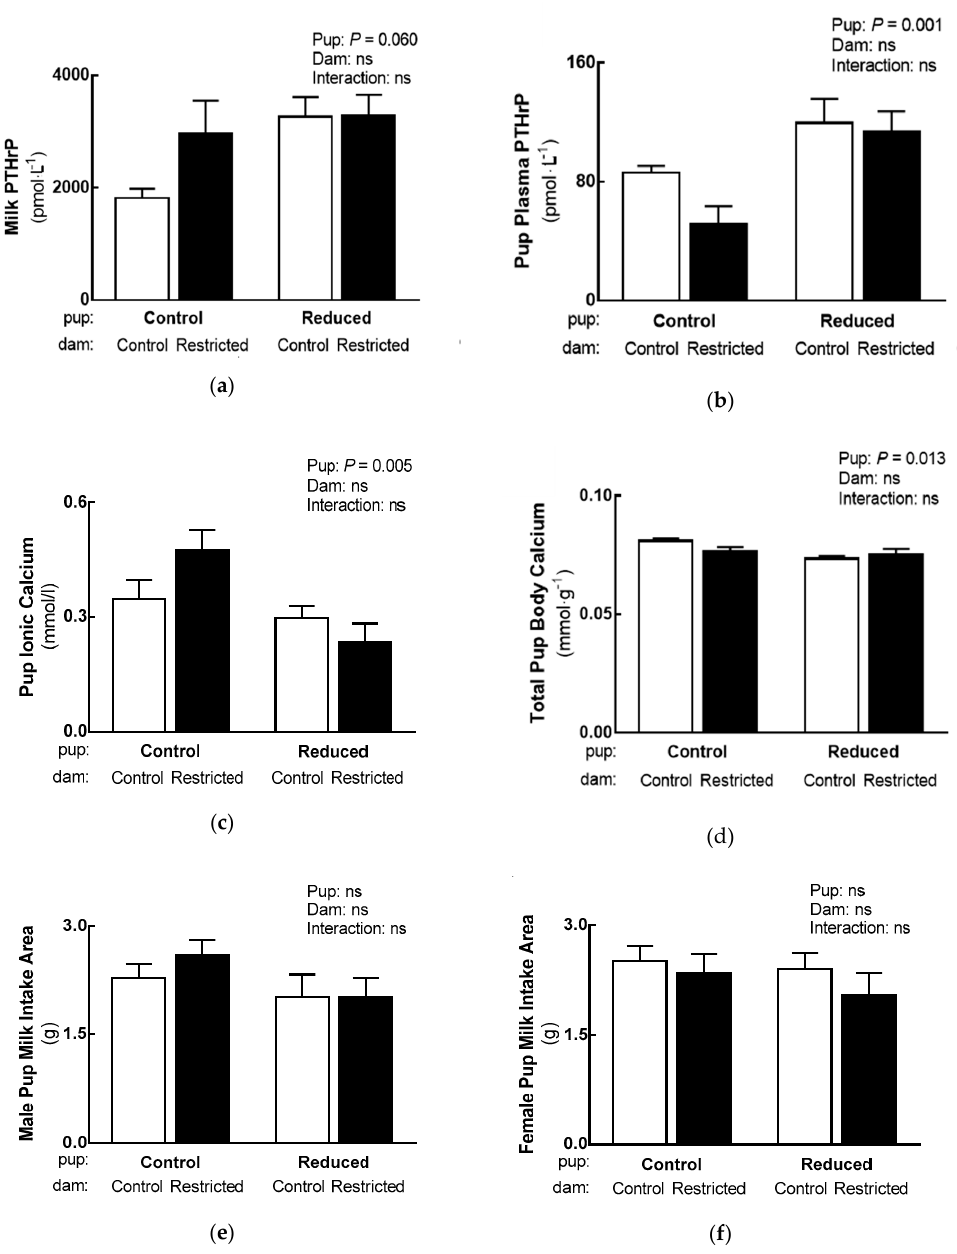
Figure 3. Effect reducing litter size has on pup calcium handling and milk intake ( n = 6–10 litter averages per group, where appropriate). ( a ) Milk and ( b ) pup PTHrP concentrations, ( c ) pup ionic calcium concentrations, ( d ) pup total body calcium and ( e , f ) pup milk intake. Data are analysed with a two-way ANOVA reporting differences between Pup (Standard and Reduced litters) and Dam (Normal and Altered milk quality/composition) groups. Data presented as the mean ± SEM, where ns is not significant. Normal milk quality/composition dams denoted by white open bars and Altered milk quality/composition dams denoted by black closed bars.